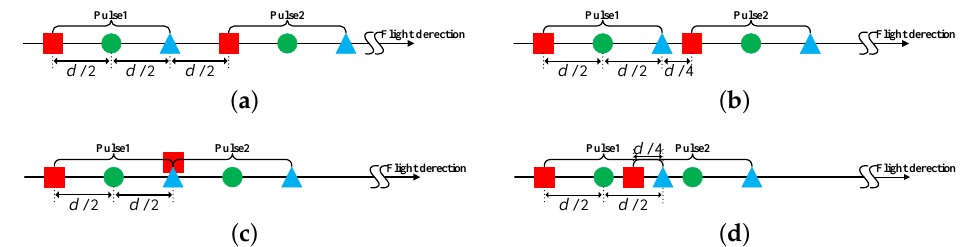
Figure 2. Spatial distribution of samples in a three-channel SAR system. ( a ) Uniform sampling. ( b ) Nonuniform sampling with spatial proximity of channels 1 and 3. ( c ) Nonuniform sampling with spatially coinciding samples of channels 1 and 3. ( d ) Nonuniform sampling with spatially interleaved samples of channels 1 and 3. The effective phase centers are depicted as squares, circles, and triangles. The three colors (red, green, and blue), respectively, represent CH-1, CH-2, and